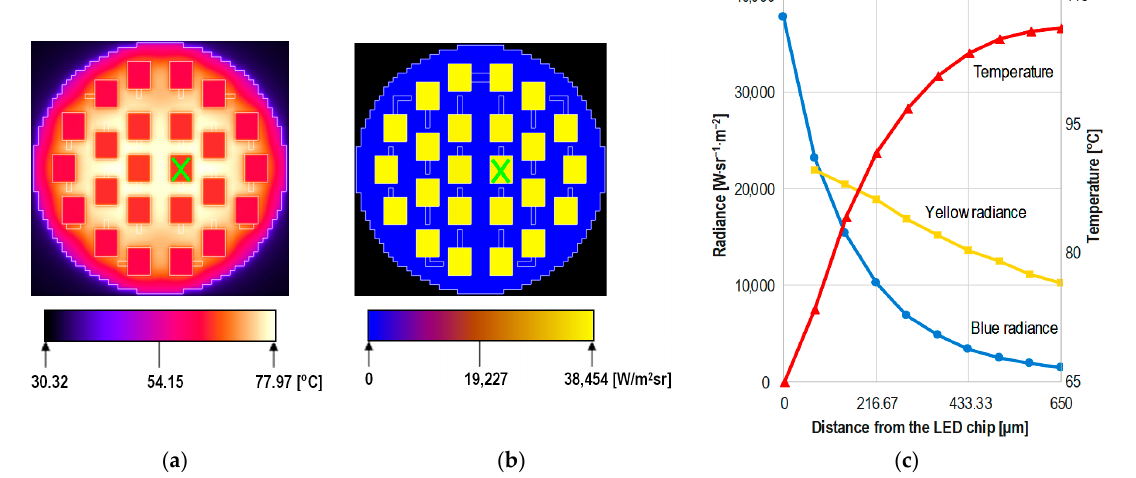
Figure 32. Simulated distributions within the CoB device: ( a ) Junction temperature of the blue LED chips; ( b ) blue radiance at the top of the LED chips; ( c ) vertical distribution of the phosphor temperature, blue radiance and yellow radiance at the location indicated by the green X marker (400 mA driving current, 25 °C ambient temperature).